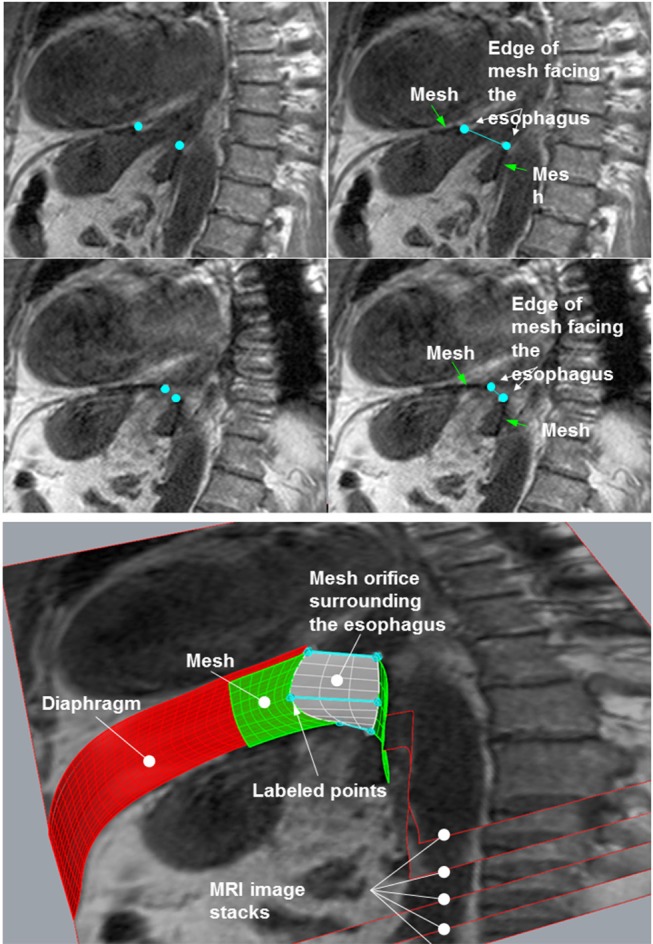
(Upper) Two images from one sequence used for analysis. Left column: the mesh edge closest to the esophagus was labeled using ImageJ (small, light gray square dots). These images were saved for control purposes. Right column: the same images with descriptions. (Lower) Calculation of the mesh orifice by stacking the images and generating a skewed plane between the marked points.